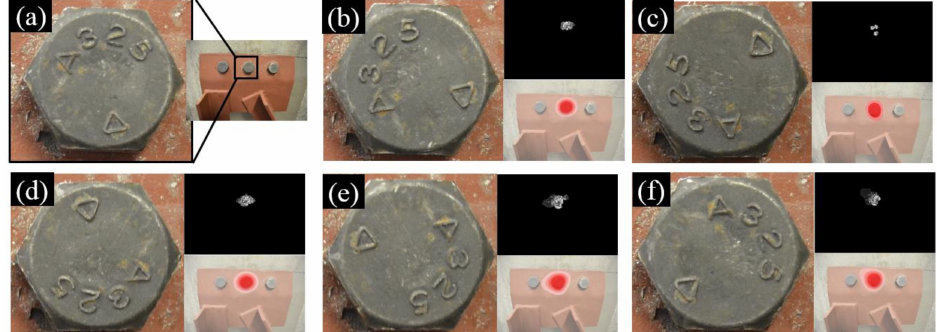
Figure 12. Detection results of a loosened bolt with different rotation angles where ( a ) is the initial status of the loosened bolt; ( b – f ) are the detection results when the loosened bolt is subjected to counterclockwise rotation of 60, 120, 180, 240, and 300 degrees, respectively. The three subfigures in Figure 12b–f represent loosened bolt ( right ), enhanced bolt loosening features ( top right ), and detection result ( bottom right